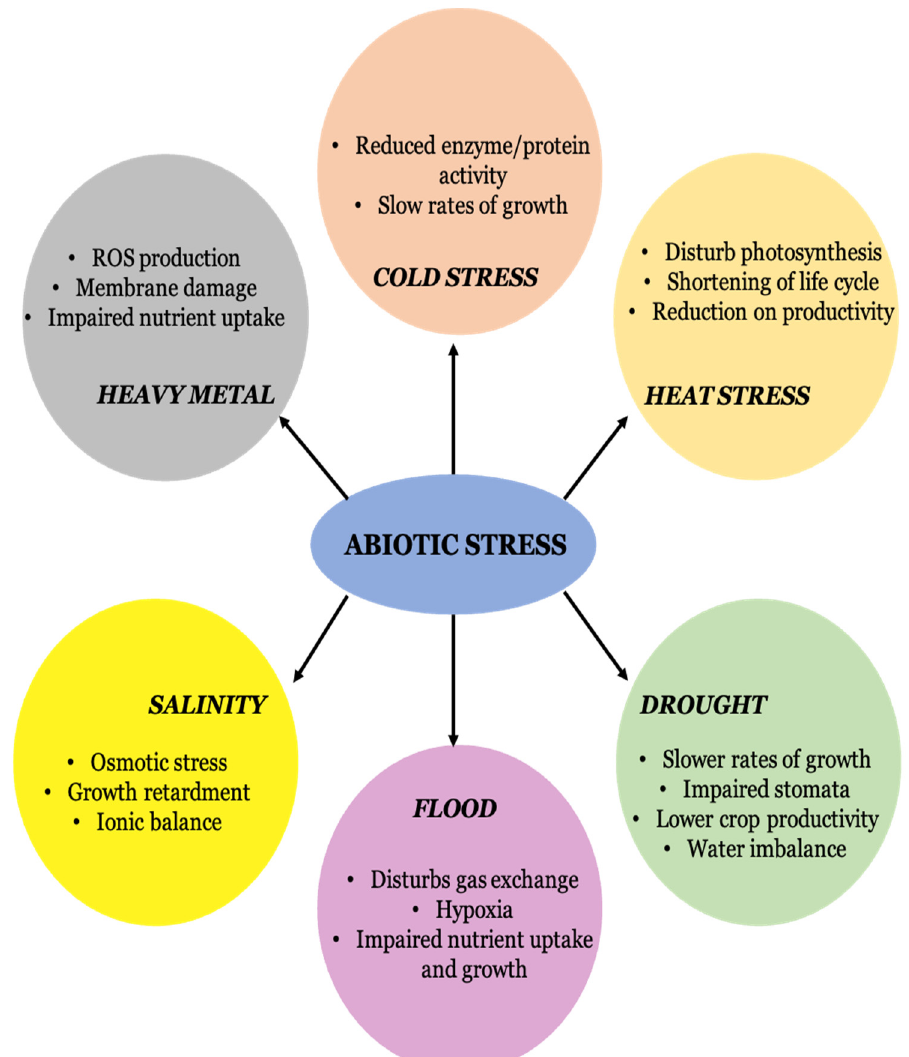
Figure 1. Abiotic stress factors and their effects on plants.